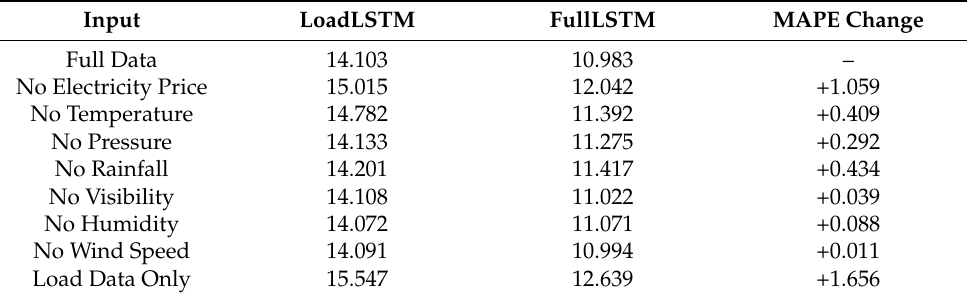
Table 4. Comparison of prediction results in terms of changes in MAPE (%) for different input data in the German